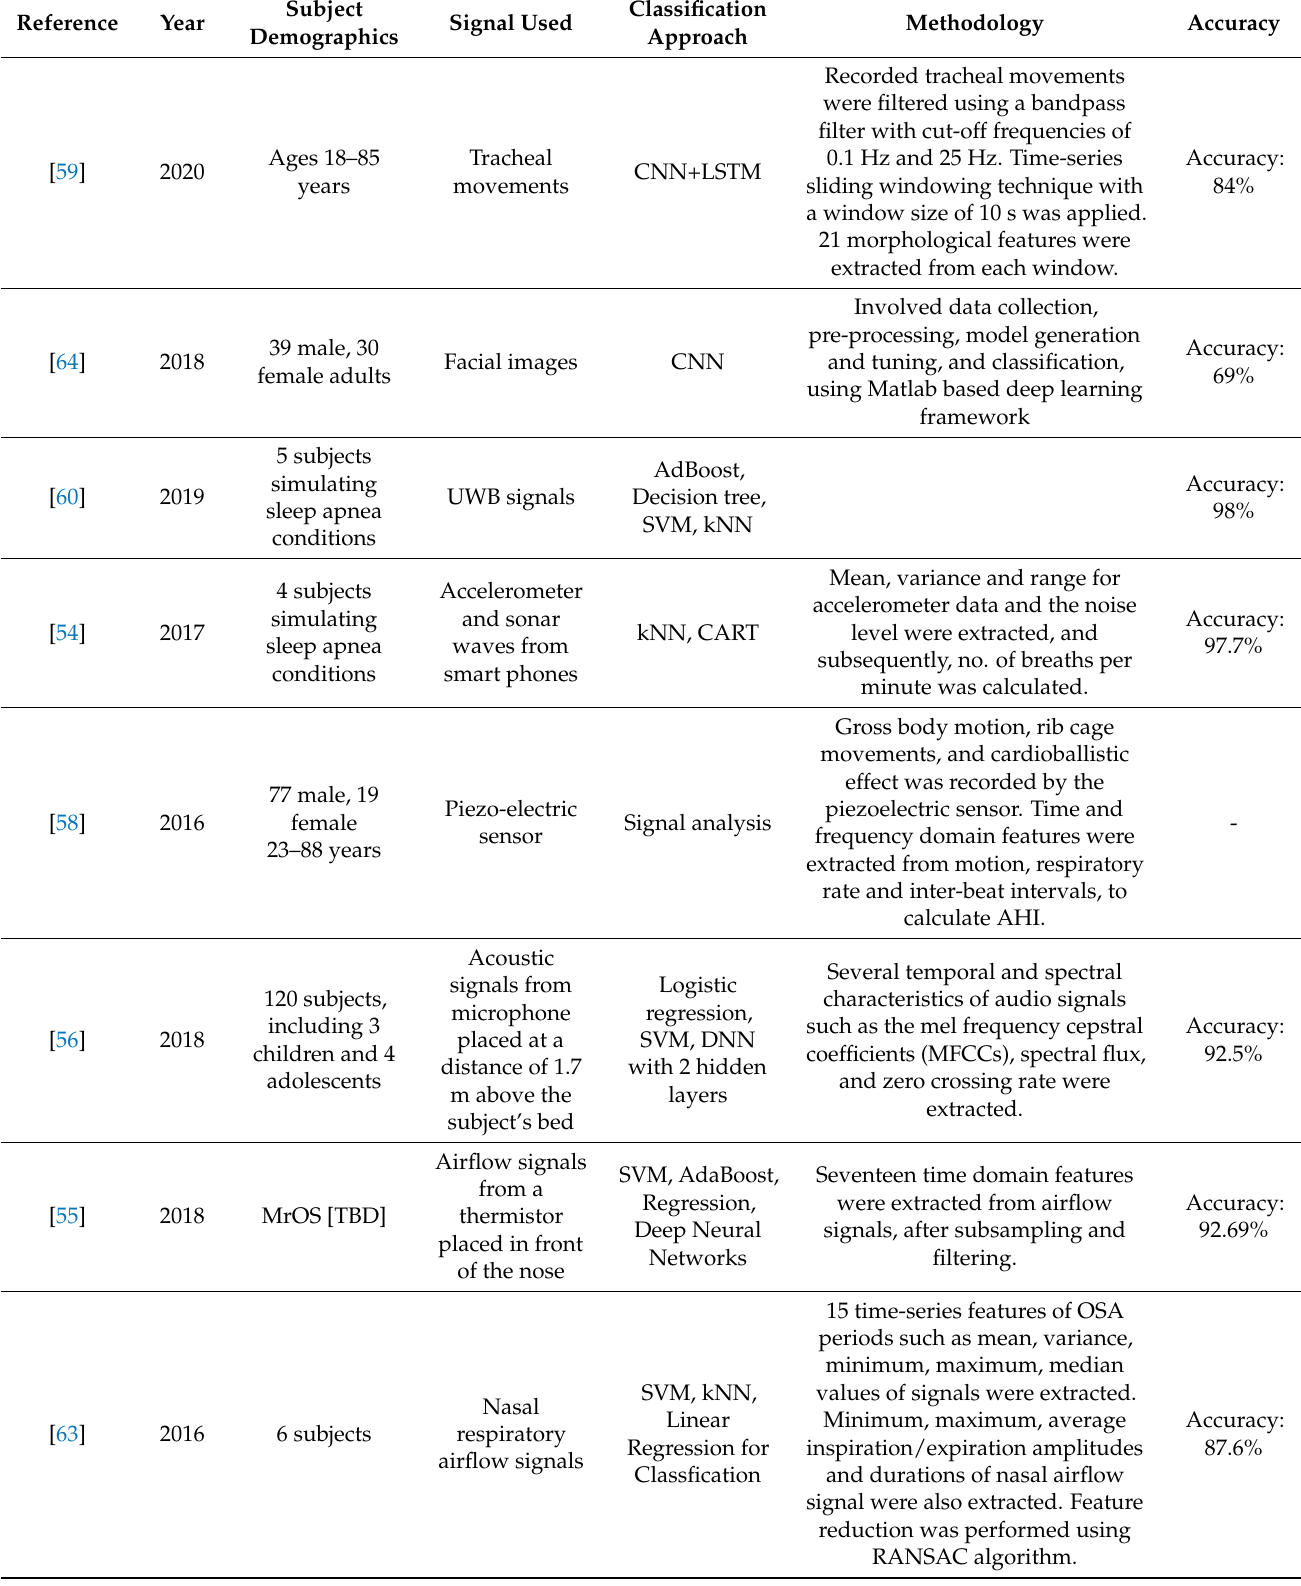
Table A2. Machine/deep learning based sleep apnea detection using environmental